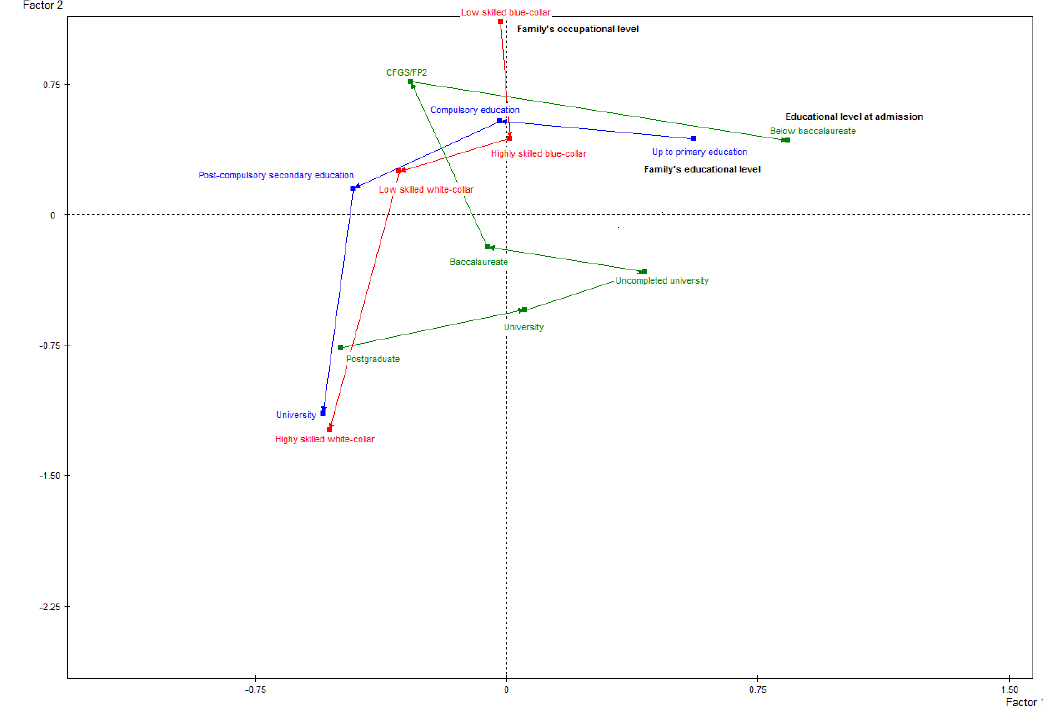
Figure 2. Projection of the variables and modalities that contribute most to factor